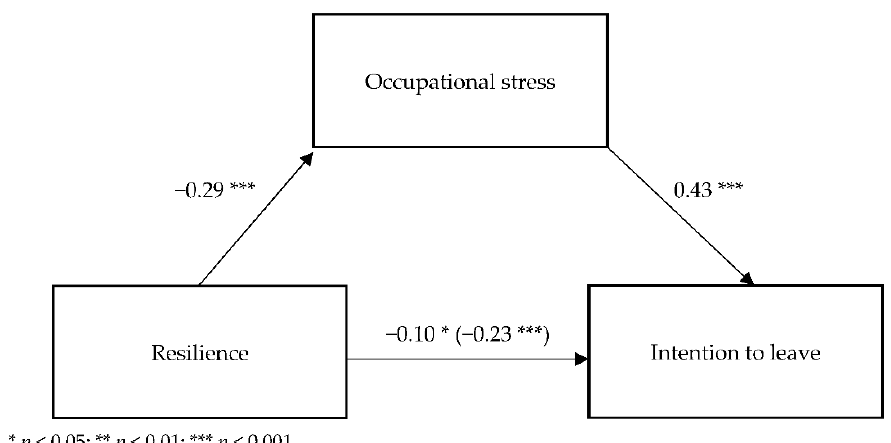
Figure 3. Standardized regression coefficients for the mediational model of NOSS in the relationship between resilience and intention to leave.